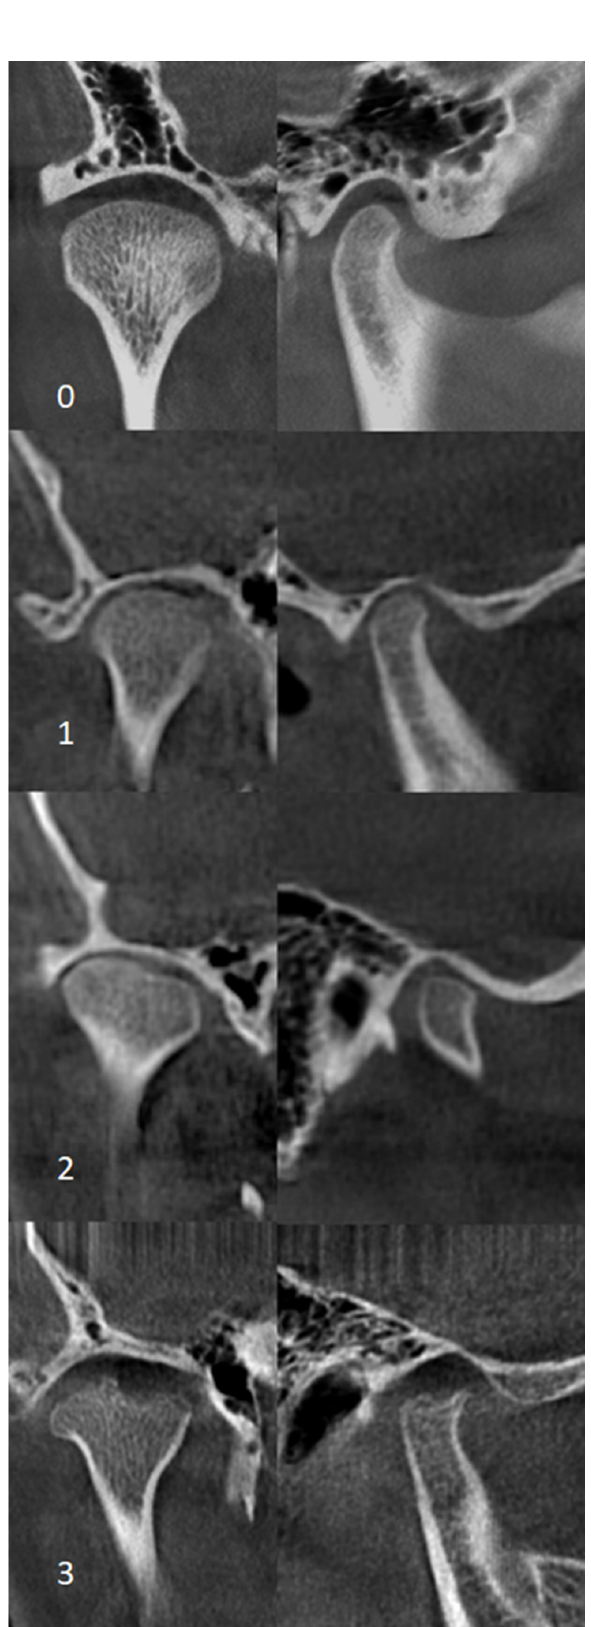
Figure 1. Coronal (left) and sagittal (right) cone beam computed tomography (CBCT) images for grading condylar morphology. 0—normal appearance, 1—cortical bony erosions, 2—flattening, 3—flattening with additional erosions.